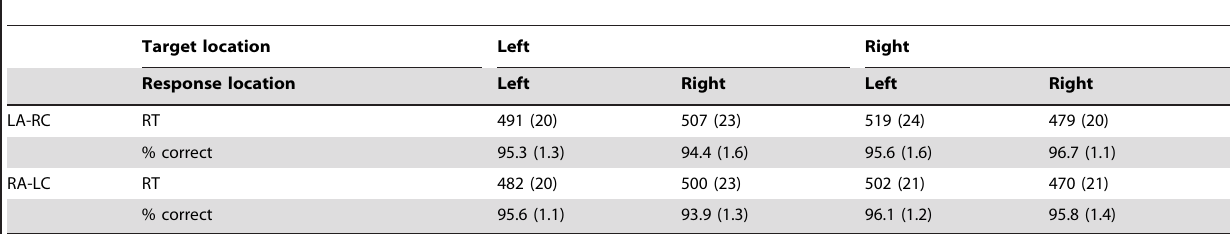
Table 3. Mean response time (RT) in milliseconds and accuracy (percentage correct) for the filler task as a function of target location (left or right) and response location (left hand or right hand). Standard errors are shown in